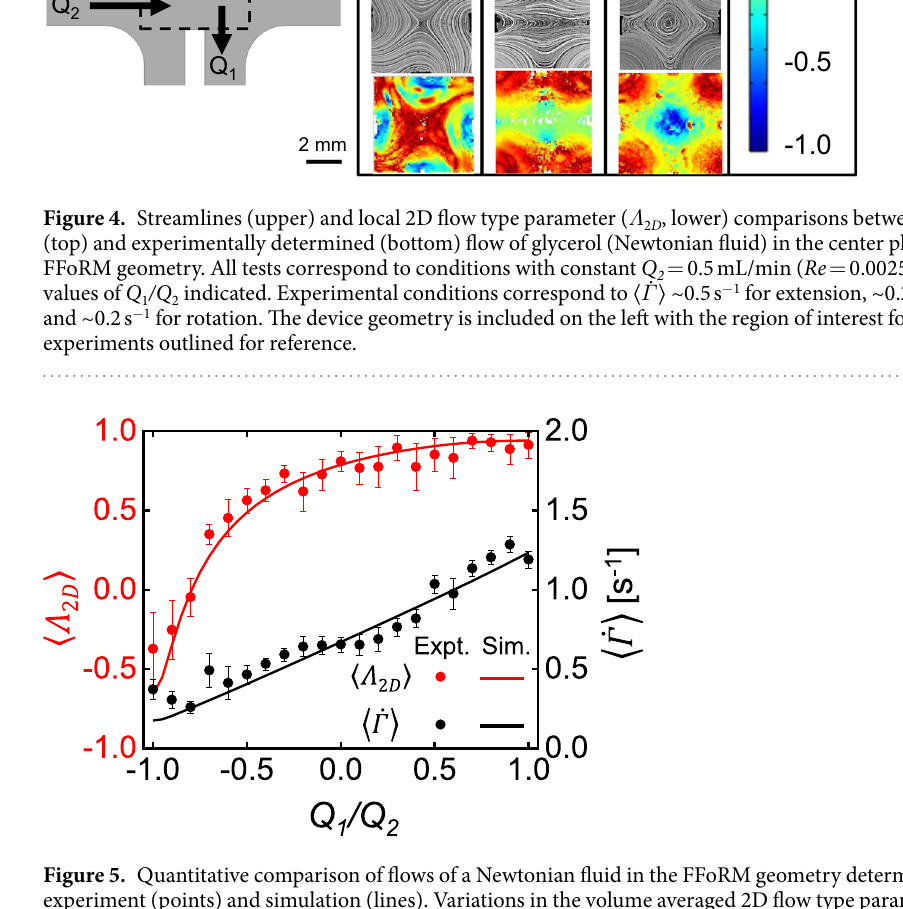
White regions in the experimental indicate area where no particles were tracked, and noise in the experimental data can be attributed to tracking errors 29 as well as small (~4%) variations in fluid velocity through the finite focal depth of measurement (~0.3 mm). Experiments show no particles moving in or out of the depth of field, indicating that, near the center plane, fully 3D flows are minimal. We note that the location of the stagnation point can shift from the center when operating at conditions near shear flow ( Λ 2 D ~ 0). We attribute this shift to small variations in ambient pressure, which can drive a shift along the center line of the device (left to right in Fig. 4) where fluid velocity is near zero. Similar difficulties were reported in Lee et al . 21 and we further note that this shift in stagnation point does not noticeably change the flow type generated at the center of the device nor the long residence time in the beam region. To quantitatively compare the flows of Newtonian fluids experimentally generated in the FFoRM with simu- lations, we calculate volume-averaged values of the flow type parameter and magnitude of the velocity gradient tensor for a region near the stagnation point in the center of the device. In the experiments, we choose a 1 mm diameter circular averaging region to match the region of uniform flow that the device was designed to achieve. In the simulations, the averaging volume is a 1 mm diameter, and 0.3 mm height cylindrical region around the nominal stagnation point in the center plane of the device chosen to match the focal depth of the experimental imaging system. Representative results are shown in Fig. 5 as a function of the ratio of volumetric flow rates Q 1 / Q 2